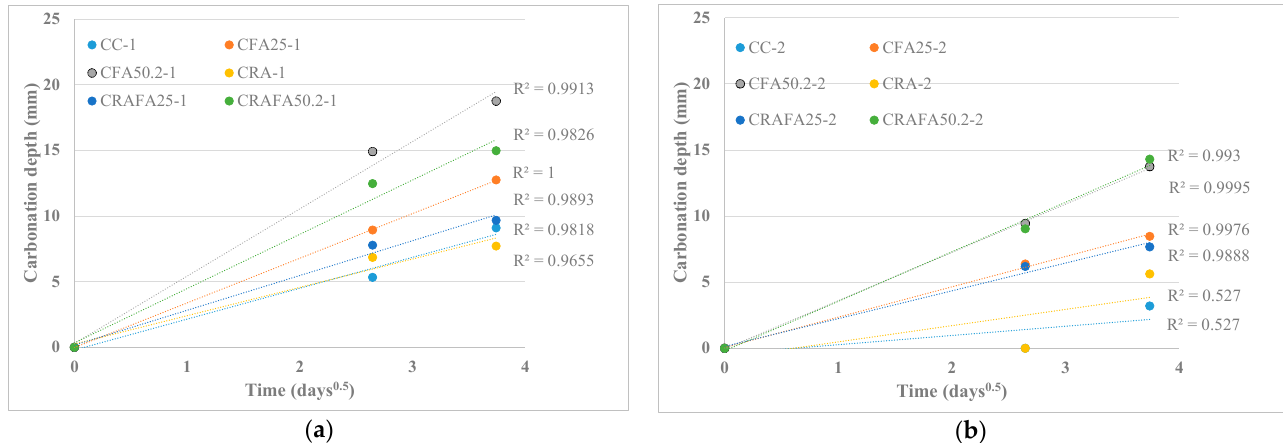
Figure 6. ( a ) Carbonation depth versus time (days 0.5 ) at 14 days of exposure to a 20% CO 2 concentration in Series 1. ( b ) Carbonation depth versus time (days 0.5 ) at 14 days of exposure to a 20% CO 2 concentration in Series 2.